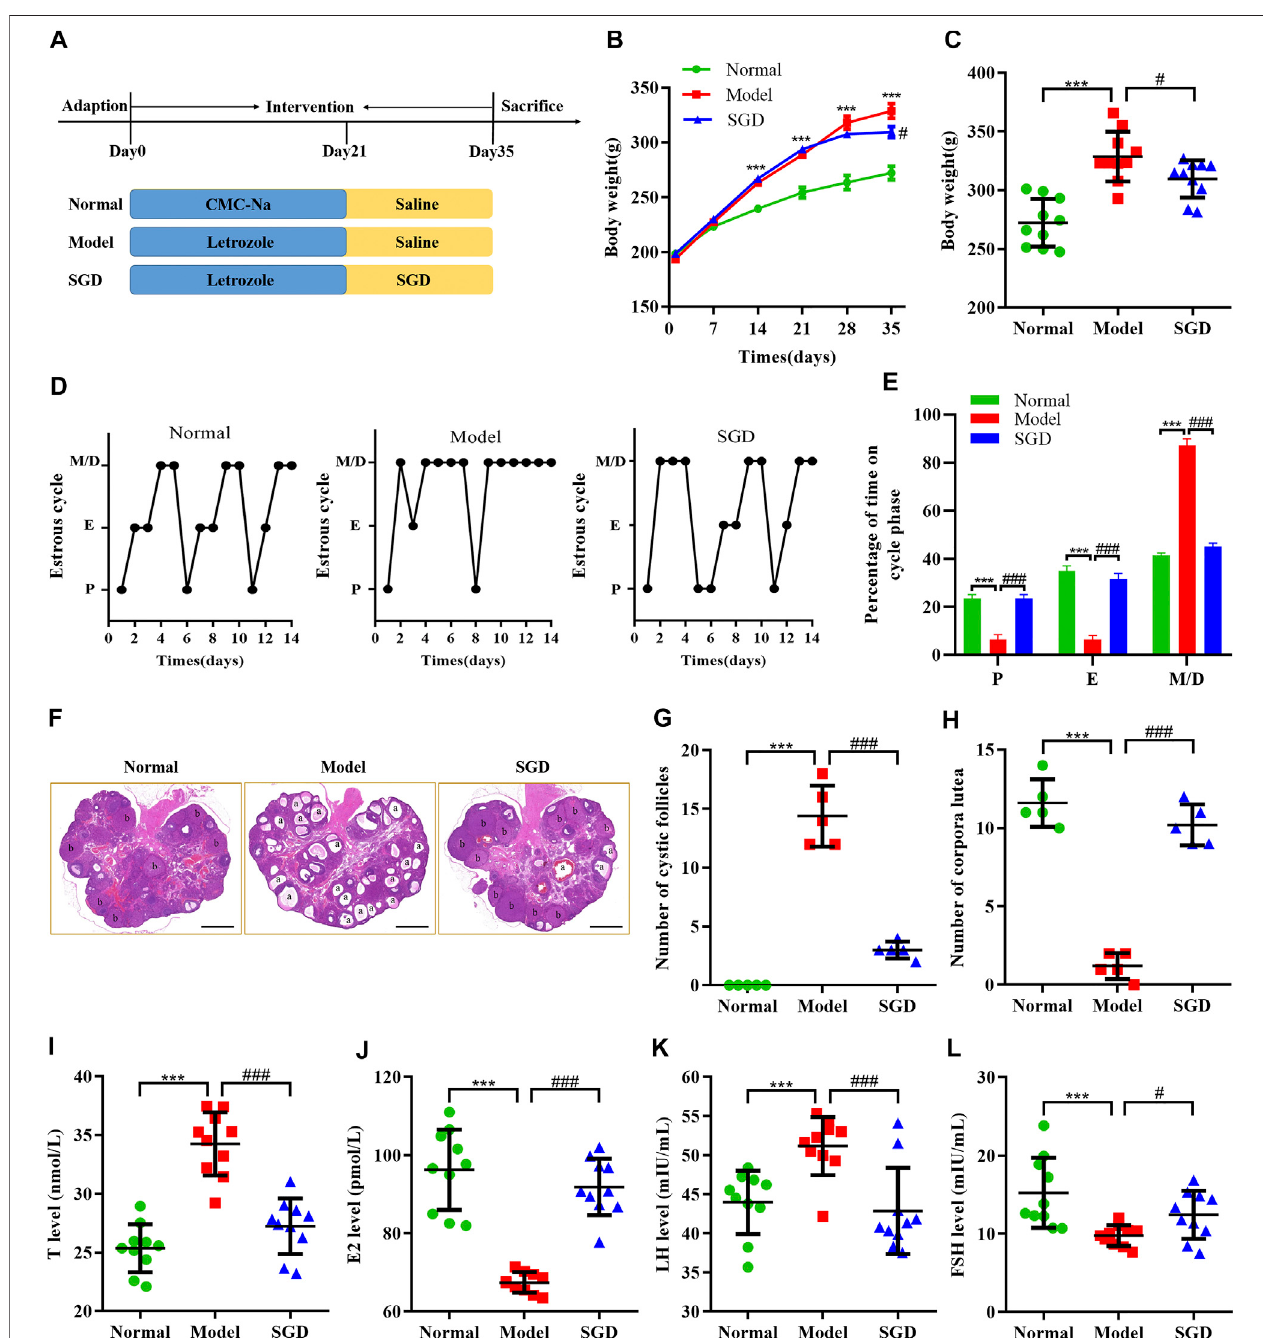
FIGURE 1 | SGD alleviated the symptoms in Letrozole-induced PCOS rats. (A) Animal groups and treatments schedule. (B,C) Effect of SGD on body weight in PCOS rats ( n (cid:1) 10). (D) Representative estrous cycles. (E) Quantitative analysis of estrous cycles ( n (cid:1) 10). (F) HE staining of representative ovaries. “ a ” indicated the appearances of cystic follicles, “ b ” indicated the appearances of corpus luteum (magni fi cation, × 10), Scale bar: 1 mm. (G) Quantitative analysis of cystic follicles ( n (cid:1) 5). (H) Quantitative analysis of corpus luteum ( n (cid:1) 5). (I – L) Serum levels of sex hormone indicators including testosterone. (T), 17 β -estradiol (E 2 ), luteinizing hormone (LH),andfolliclestimulatinghormone(FSH)weredeterminedbyusingELISAkits( n (cid:1) 10).Datawerepresentedasmean ± SEM.*** p < 0.001vs.normalgroup, # p < 0.05 and ### p < 0.001 vs. PCOS model